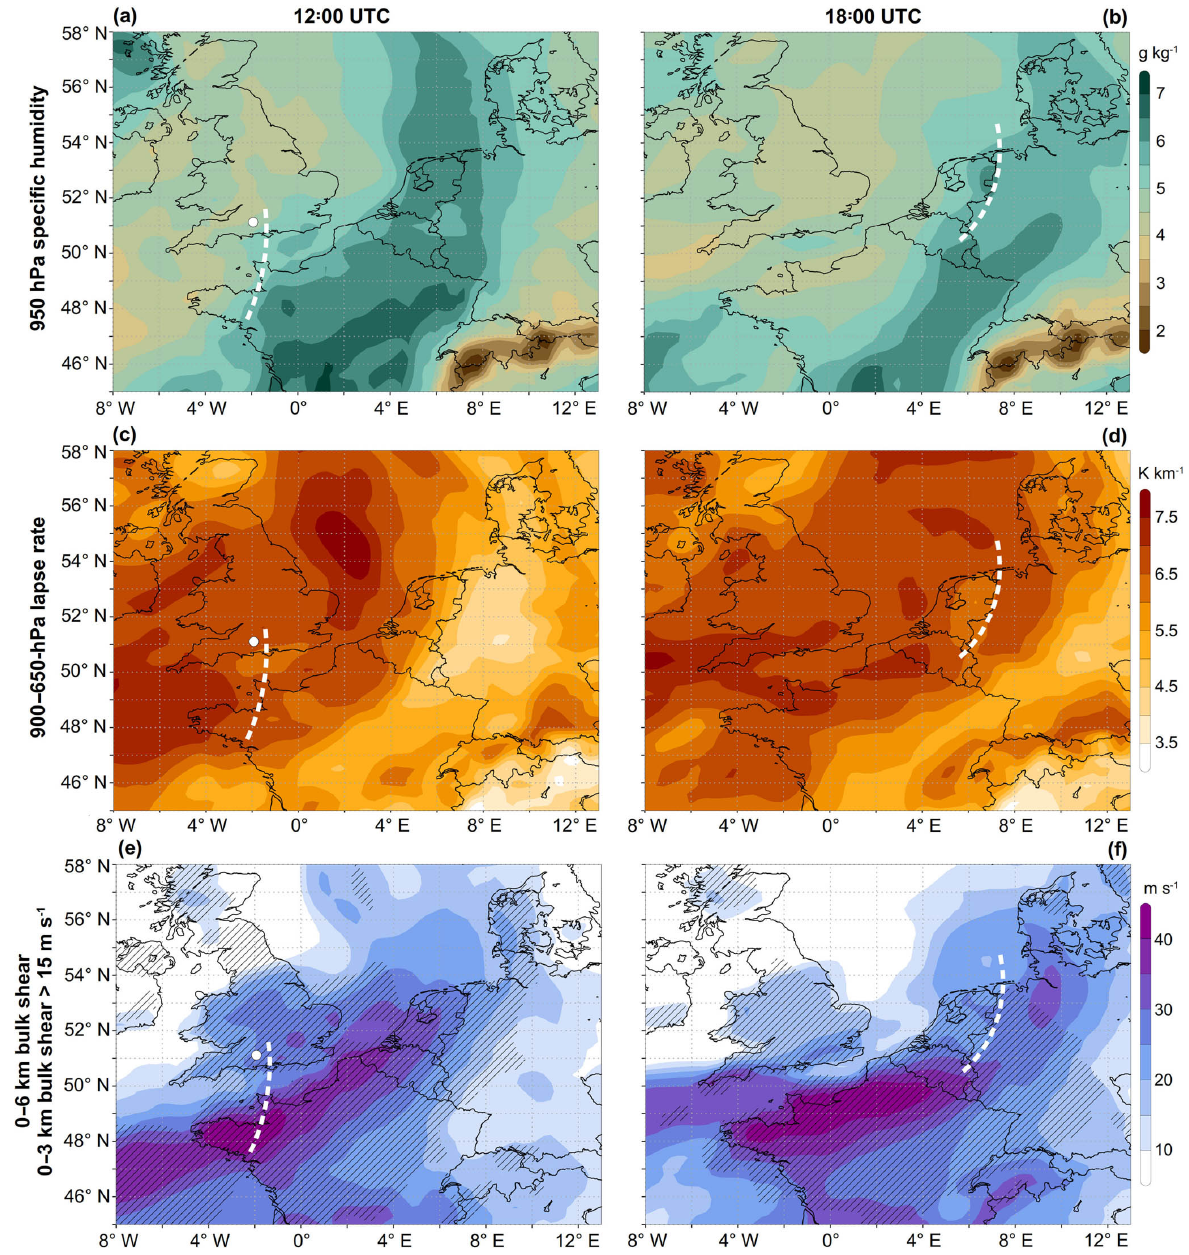
Figure 5. ERA5 reanalysis of (a, b) 950hPa specific humidity (gkg − 1 ) , (c, d) 900–650hPa lapse rate (Kkm − 1 ), (e, f) 0–6km bulk shear (ms − 1 ; shaded) and (e, f) 0–3km bulk shear larger than 15ms − 1 (hatched areas) at (a, c, e) 12:00UTC and (b, d, f) 18:00UTC on 3 January 2014. The white dot in (a) , (c) and (e) denotes the location of the sounding shown in Fig. 6. The dashed white line indicates the position of the surface trough according to the UK Met Office surface analysis shown in Fig.